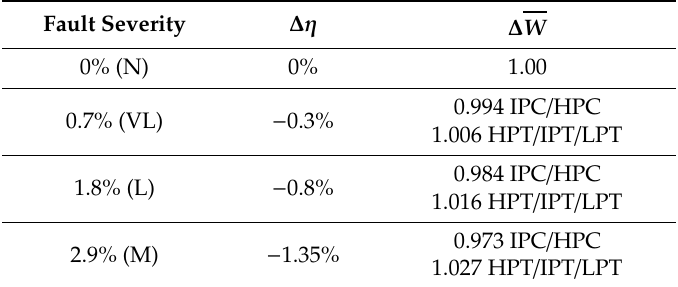
Table 4. Simulated fault scenarios.